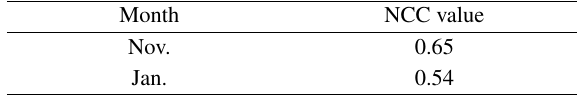
Table 13 NCC value between the English tweets (classified as nonself) and count of actual hospital visits.